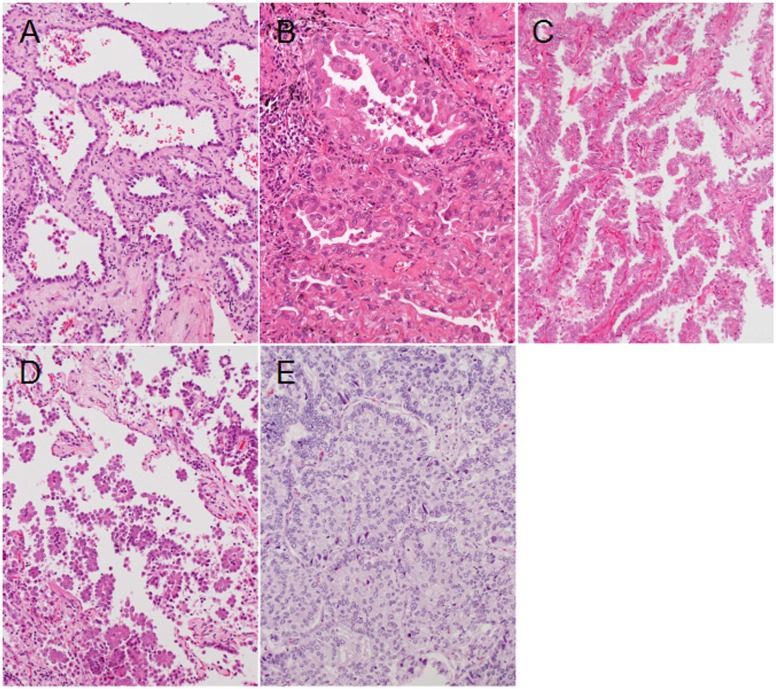
Representative appearances of the major histological subtypes of lung adenocarcinoma (hematoxylin and eosin stain, ×200).A, The lepidic subtype is characterized by the extension of neoplastic cells along the surface of the alveolar walls; B, The acinar subtype is characterized by tubular or glandular structures invading a fibrous stroma; C, The papillary subtype is characterized by the extension of neoplastic cells on the surfaces of fibrovascular cores; D, The micropapillary subtype is characterized by the formation of tufted papillary structures that lack a central fibrovascular core and float in the alveolar space; E, The solid subtype is characterized by the formation of solid nests consisting of neoplastic cells.